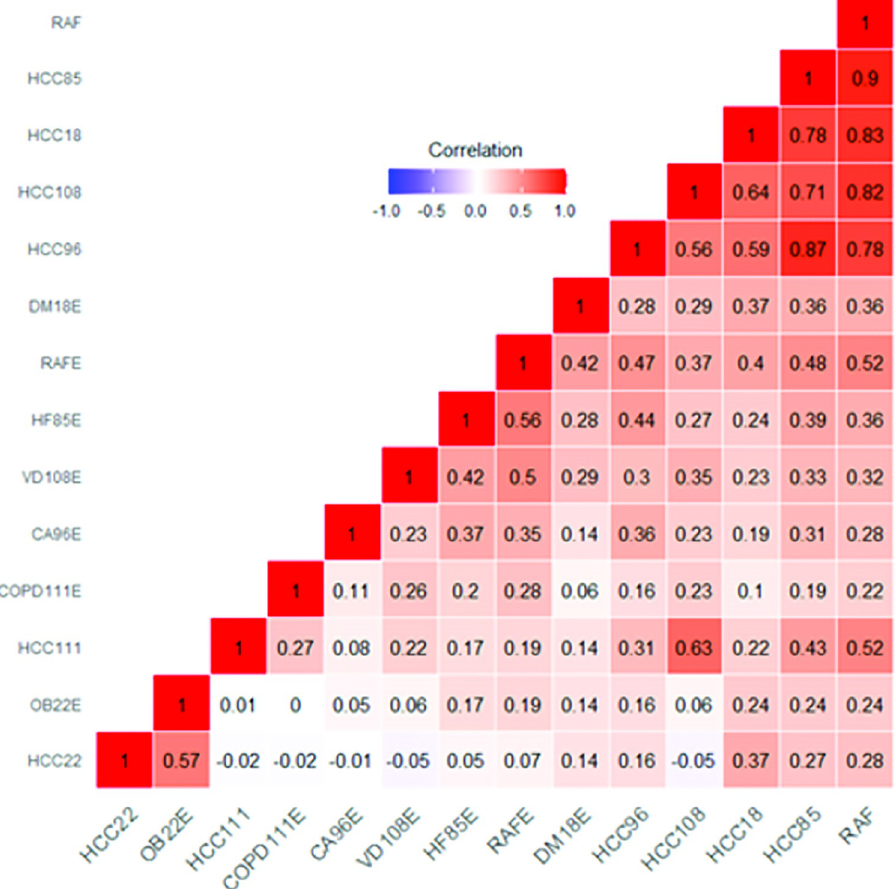
Fig 4. Correlation heatmap of electronic health record (EHR) vs the deep learning (DL) model for both cohorts. The correlation matrix shows Spearman’s correlation coefficient values across the predicted comorbidities and risk adjustment factor (RAF) scores between the EHR data and the convolutional neural network (CNN) frontal radiograph model. Please see the discussion for further details. Blue indicates a negative correlation, red indicates a positive correlation. Abbreviations: DM18E = diabetes with complications, OBS22E = morbid obesity, HF85E = congestive heart failure, CA96E = cardiac arrhythmias, CA96E = vascular disease, COPD111E = chronic obstructive pulmonary disease, RAF = risk adjustment